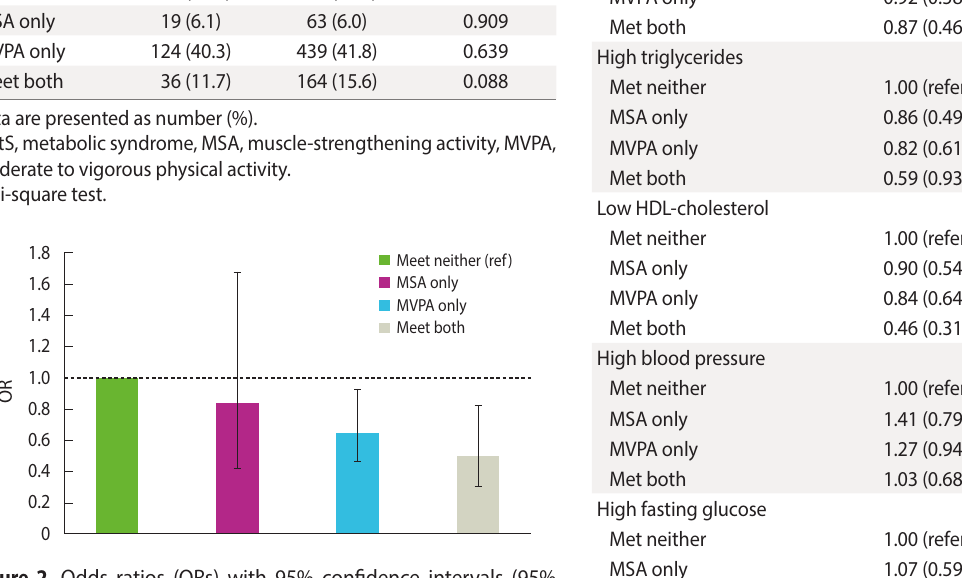
Figure 2. Odds ratios (ORs) with 95% confidence intervals (95% CIs) for metabolic syndrome among individuals meeting MSA